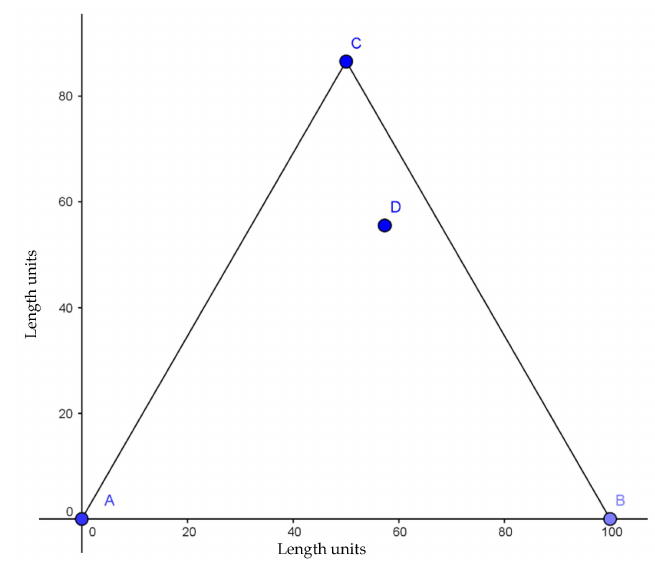
Figure 5. Location of Vertices A, B and C and the, defect D.